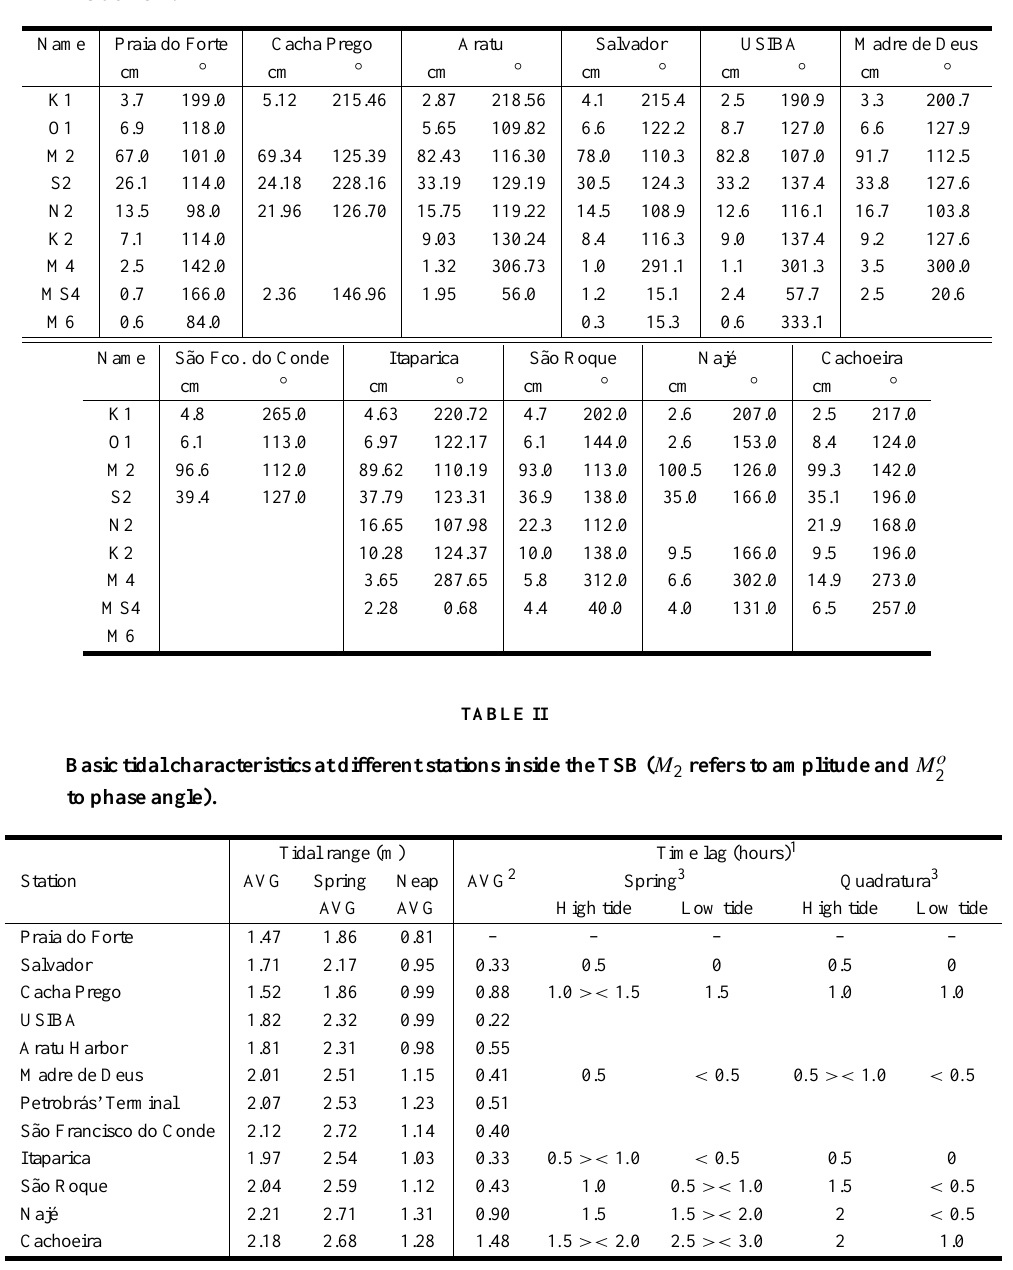
Amplitude and phase angle of some important tidal constituents at some stations outside and inside